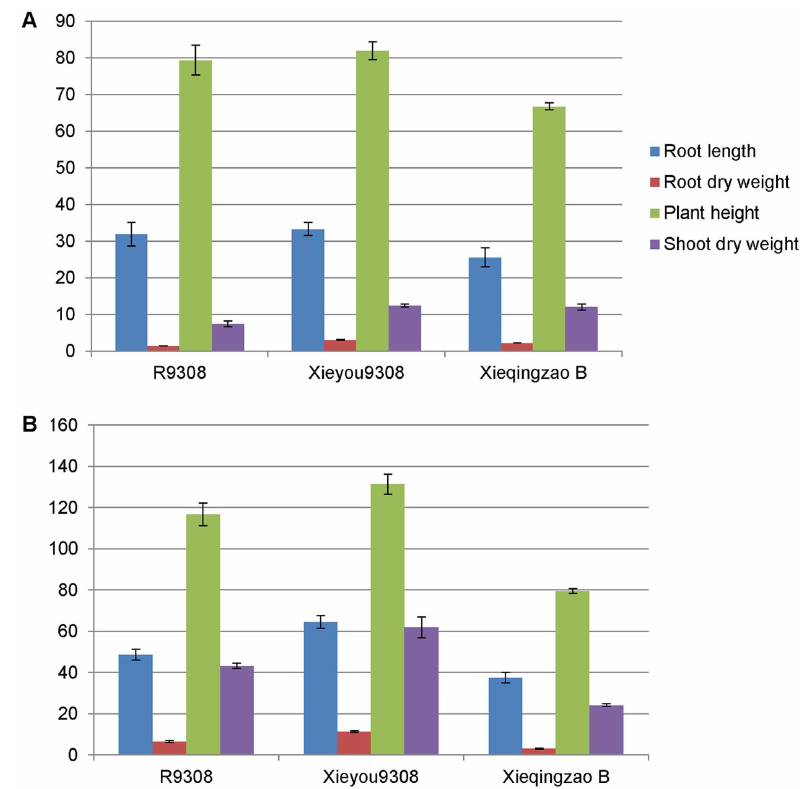
Figure 2. Illustration of heterosis in Xieyou9308 at tillering (A) and heading (B) stages.